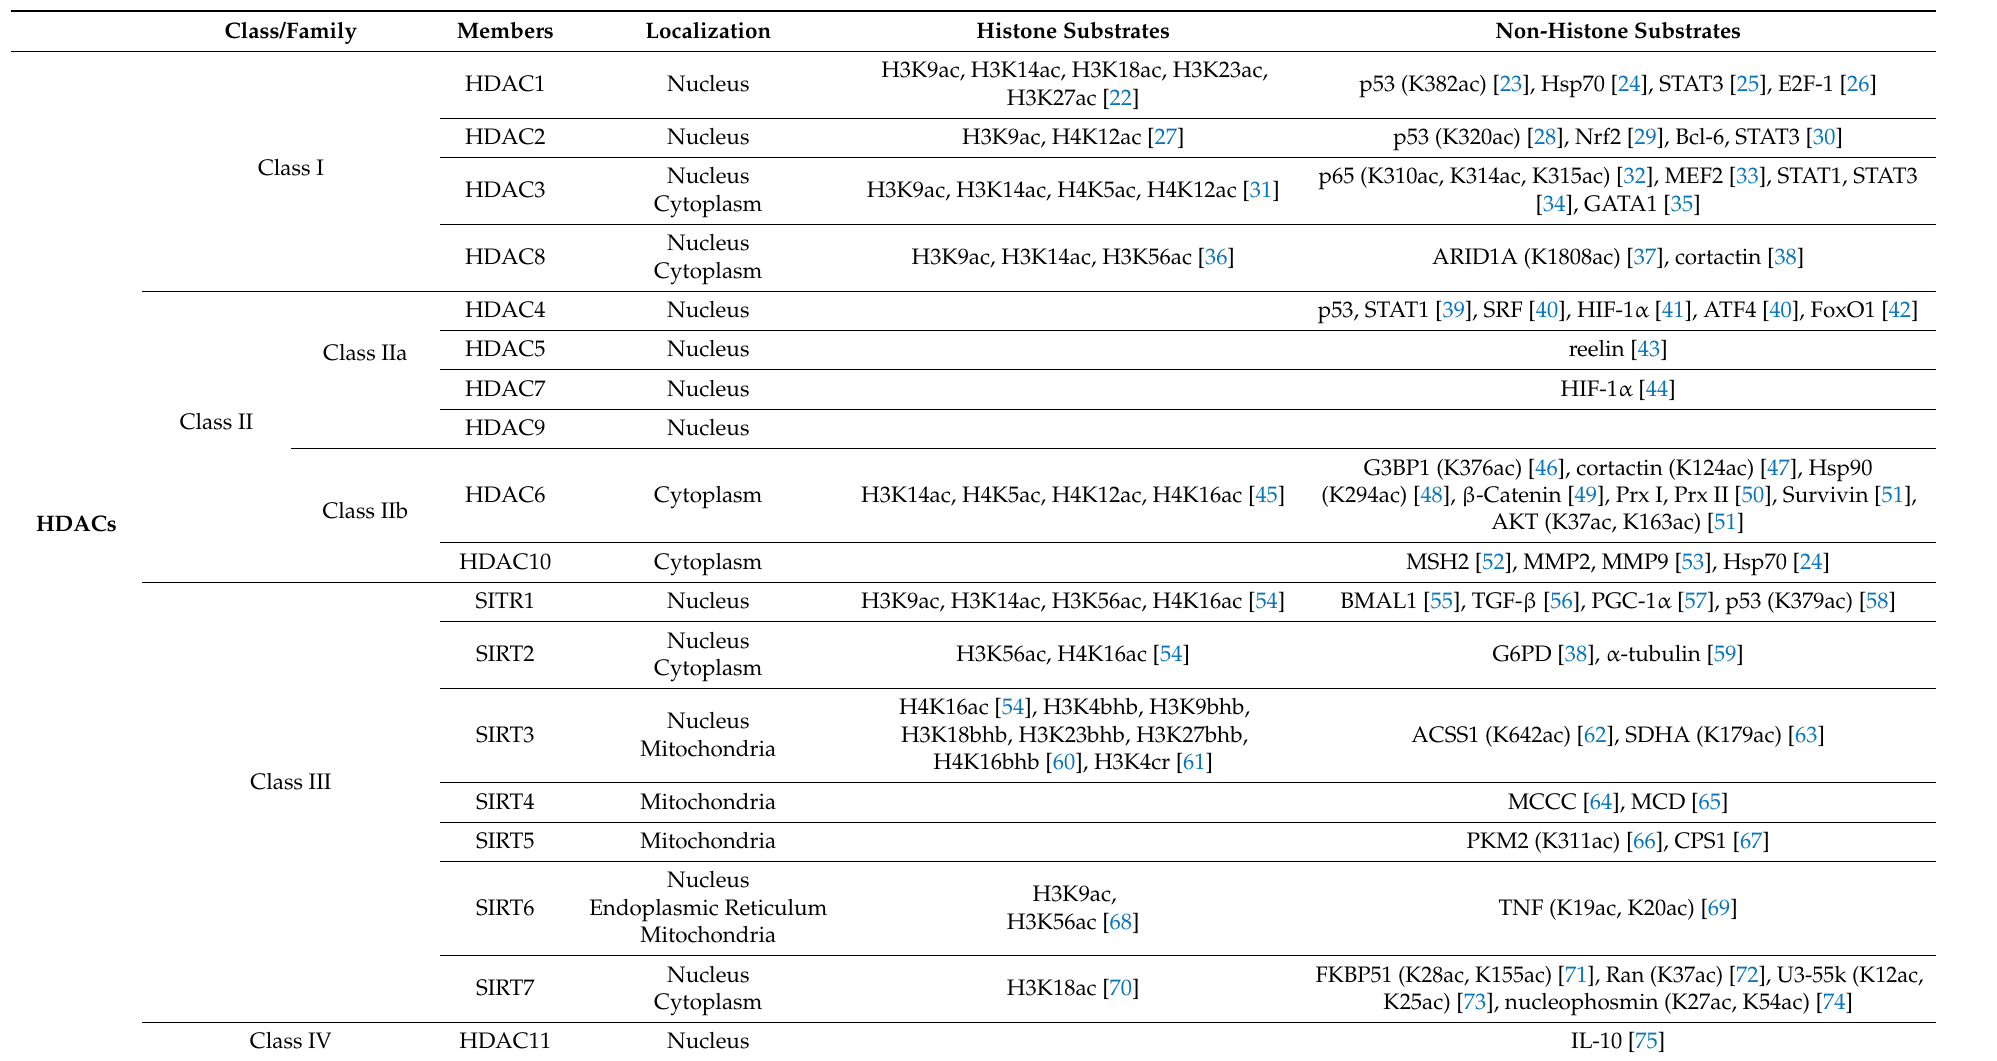
Table 1. Substrates of HDACs and